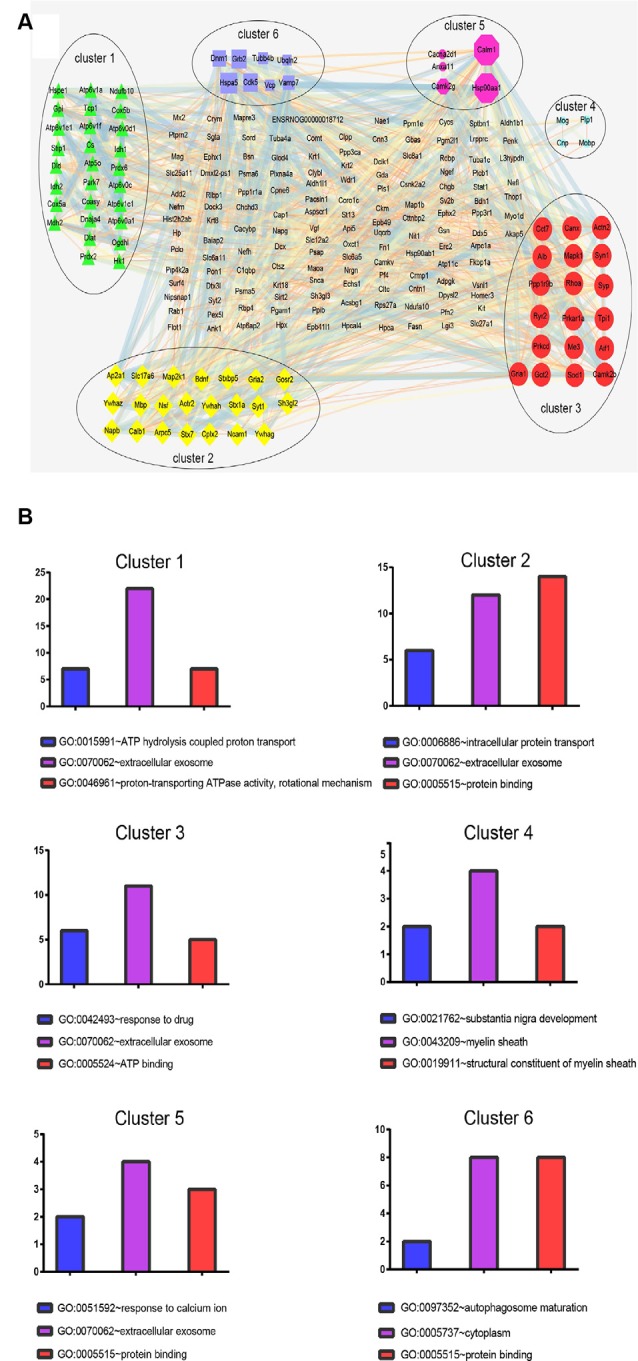
Protein cluster analysis with MCODE to find highly interconnected subnetworks involved in acute IS. (A) The six clusters in the PPI network are labeled with six oval shapes. (B) Statistical summary of the GO terms associated with the six clusters of DEPs, represented in bar charts. Data represent GO terms with the highest numbers of proteins. Bar color highlights the GO terms: blue, biological process; purple, cellular components; and red, molecular function. Y-axis represents the number of DEP candidates.